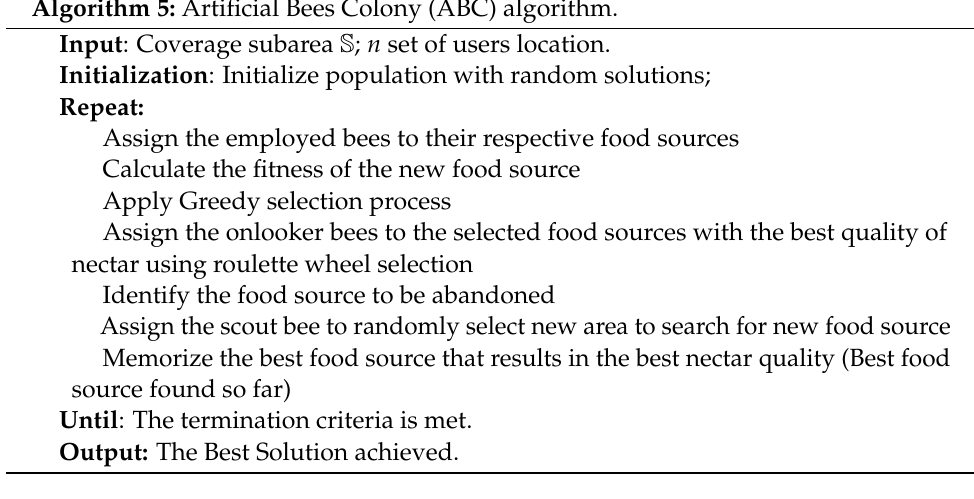
Algorithm 5: Artificial Bees Colony (ABC)